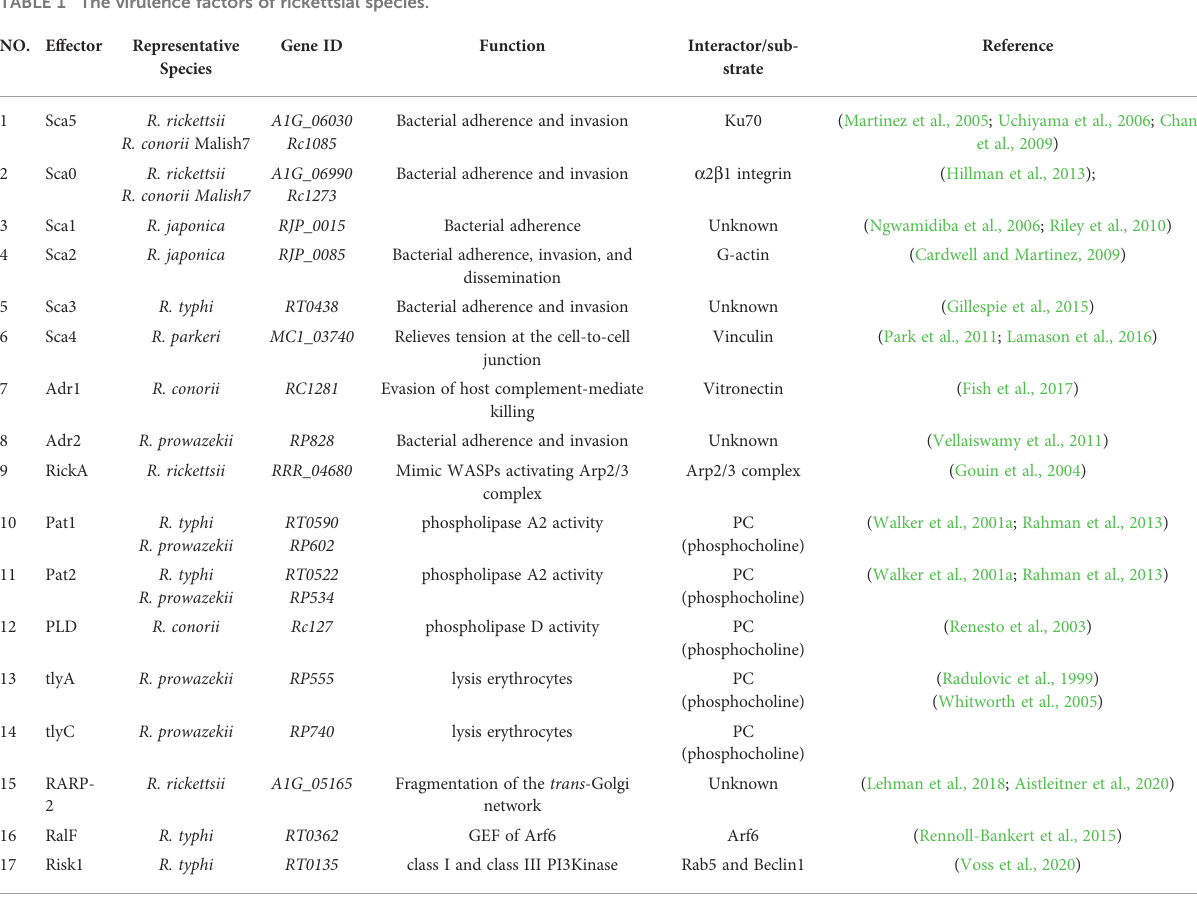
TABLE 1 The virulence factors of rickettsial